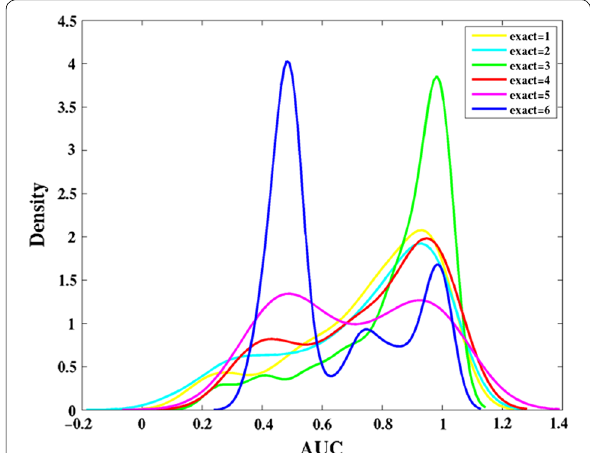
Fig. 5 Kernel density estimation showing the changes in distribu- tion of AUC scores for RD-Metabolizer predictions as the number of fingerprint levels to match exactly is